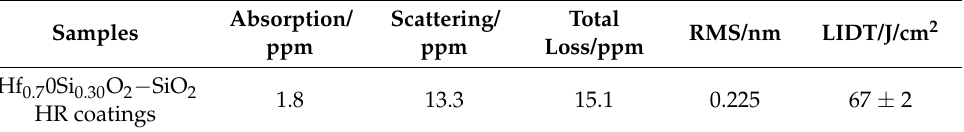
Table 3. Optical properties of the 1064-nm high reflective coatings consisting of SiO 2